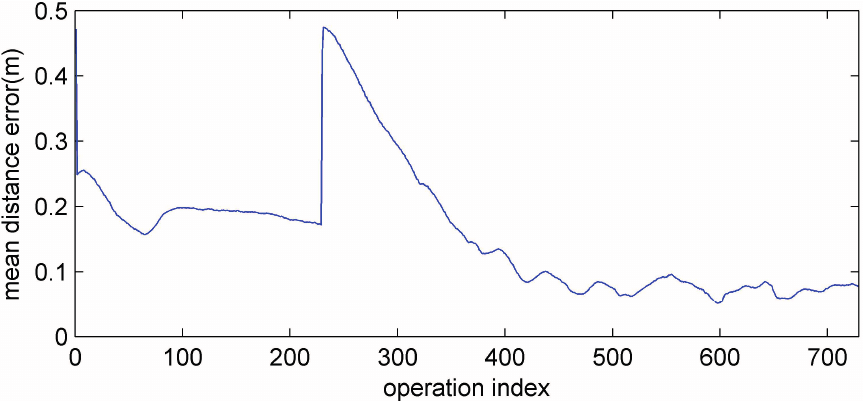
Figure 19. The mean distance error of the